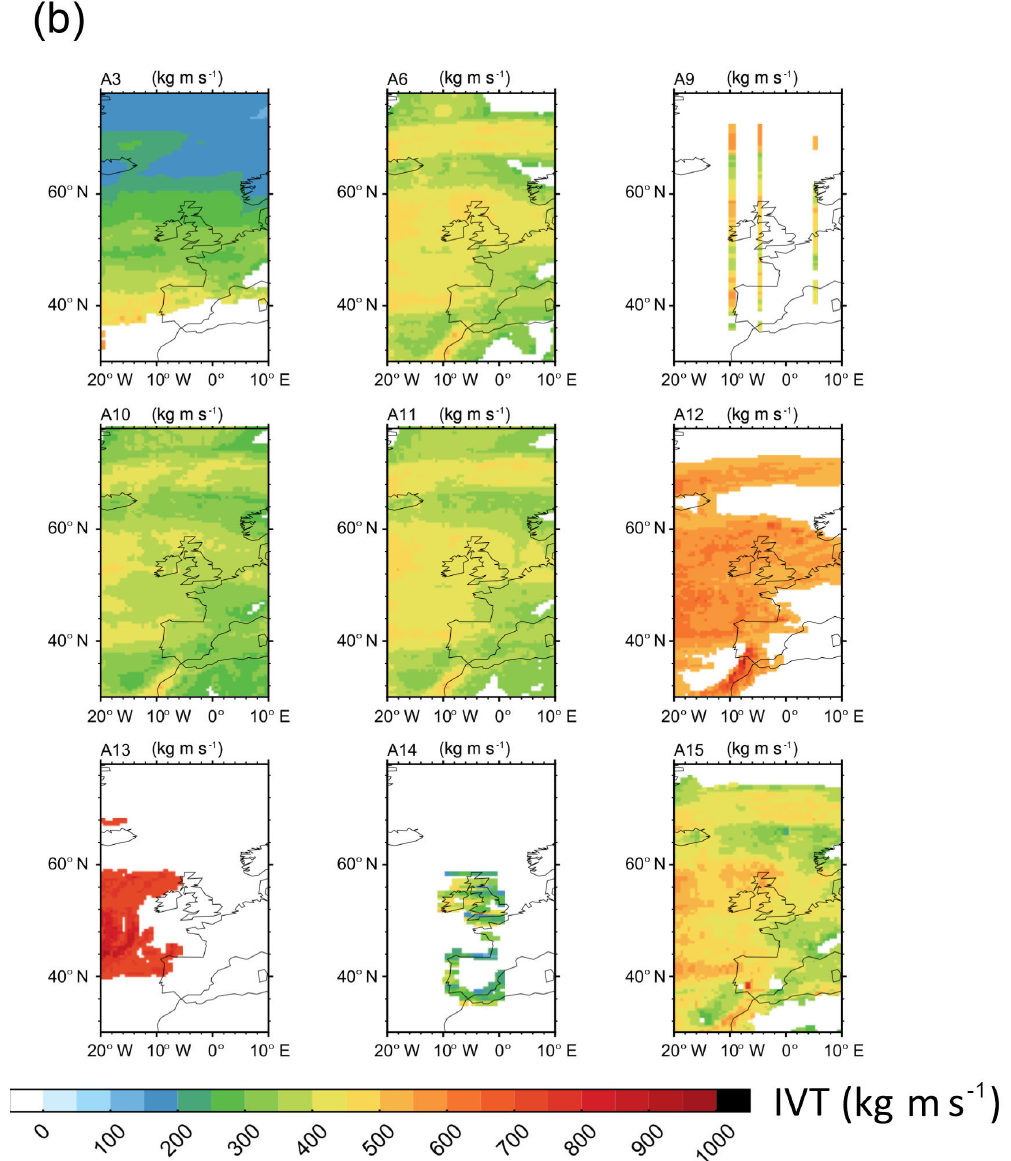
Figure 5. (a) Composite MERRA-2 IVT (kgm − 1 s − 1 ) for western North America for all AR occurrences for all grid points where ARs are detected. Algorithm IDs are found in Table 1. Algorithm A14 computes AR detection only for landfalling ARs at coastline grid points. The absence of color indicates no AR detection. (b) Same as panel (a) except for North Atlantic ARs. Algorithm A9 detects ARs at reference meridians. Note that the number of algorithms in this figure differs from panel (a) due to the regional constraint of the respective